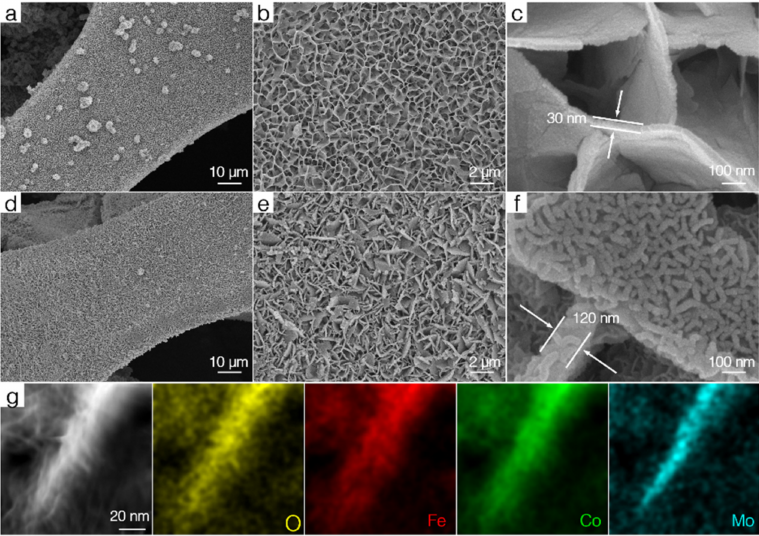
Figure 2. SEM images of ( a – c ) CoMoO 4 and ( d – f ) CoMoO 4 @ γ -FeOOH. ( g ) HAADF-STEM and the corresponding EDS mapping images of CoMoO 4 @ γ